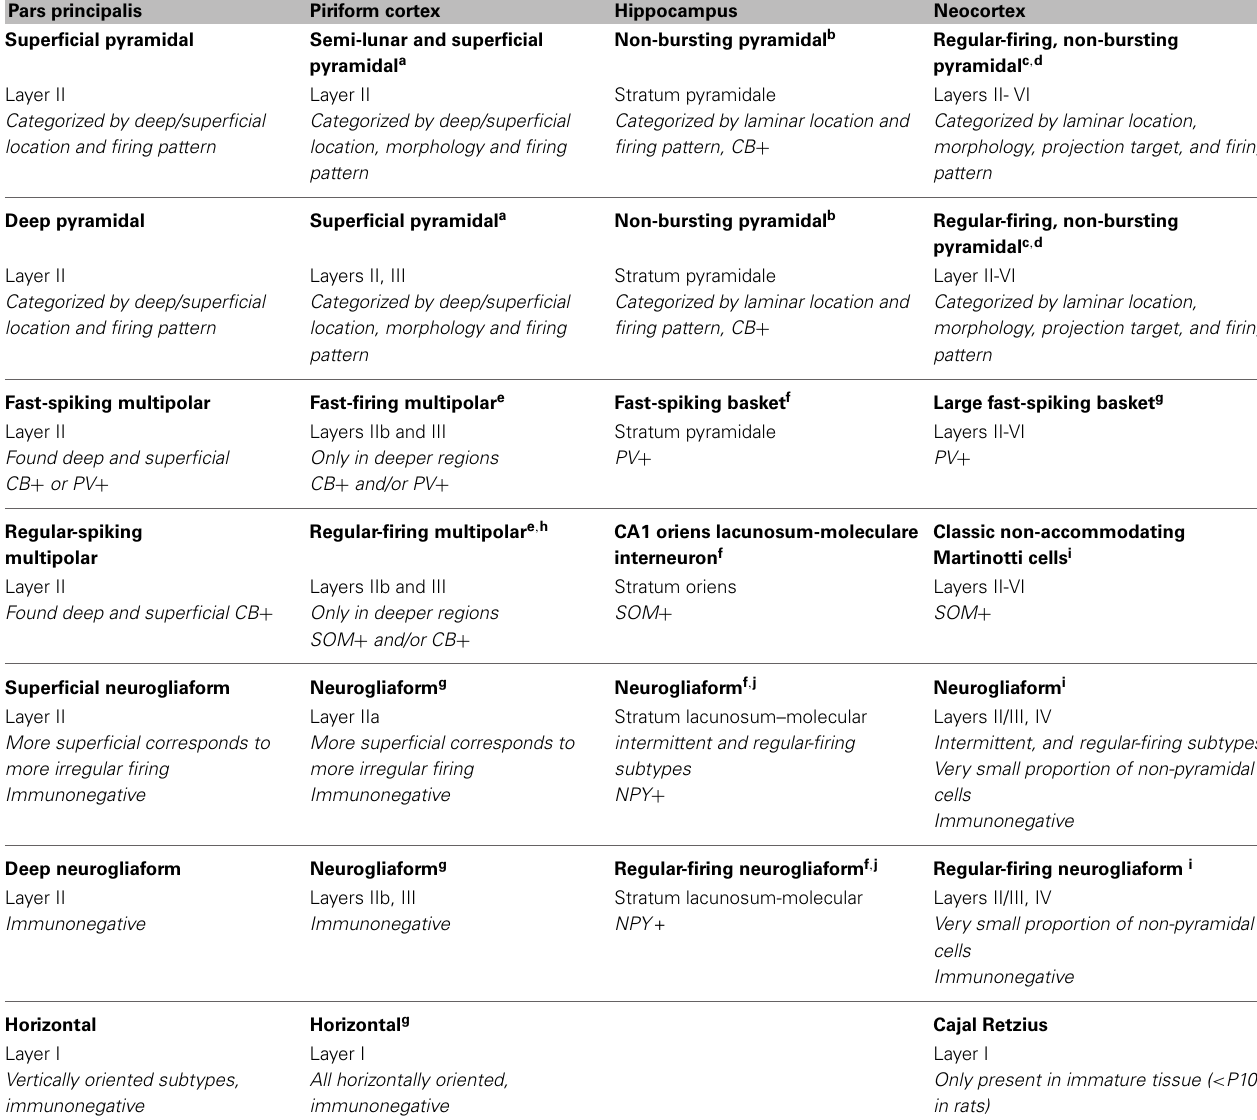
Table 3 | Cell types in other brain regions most similar to pars